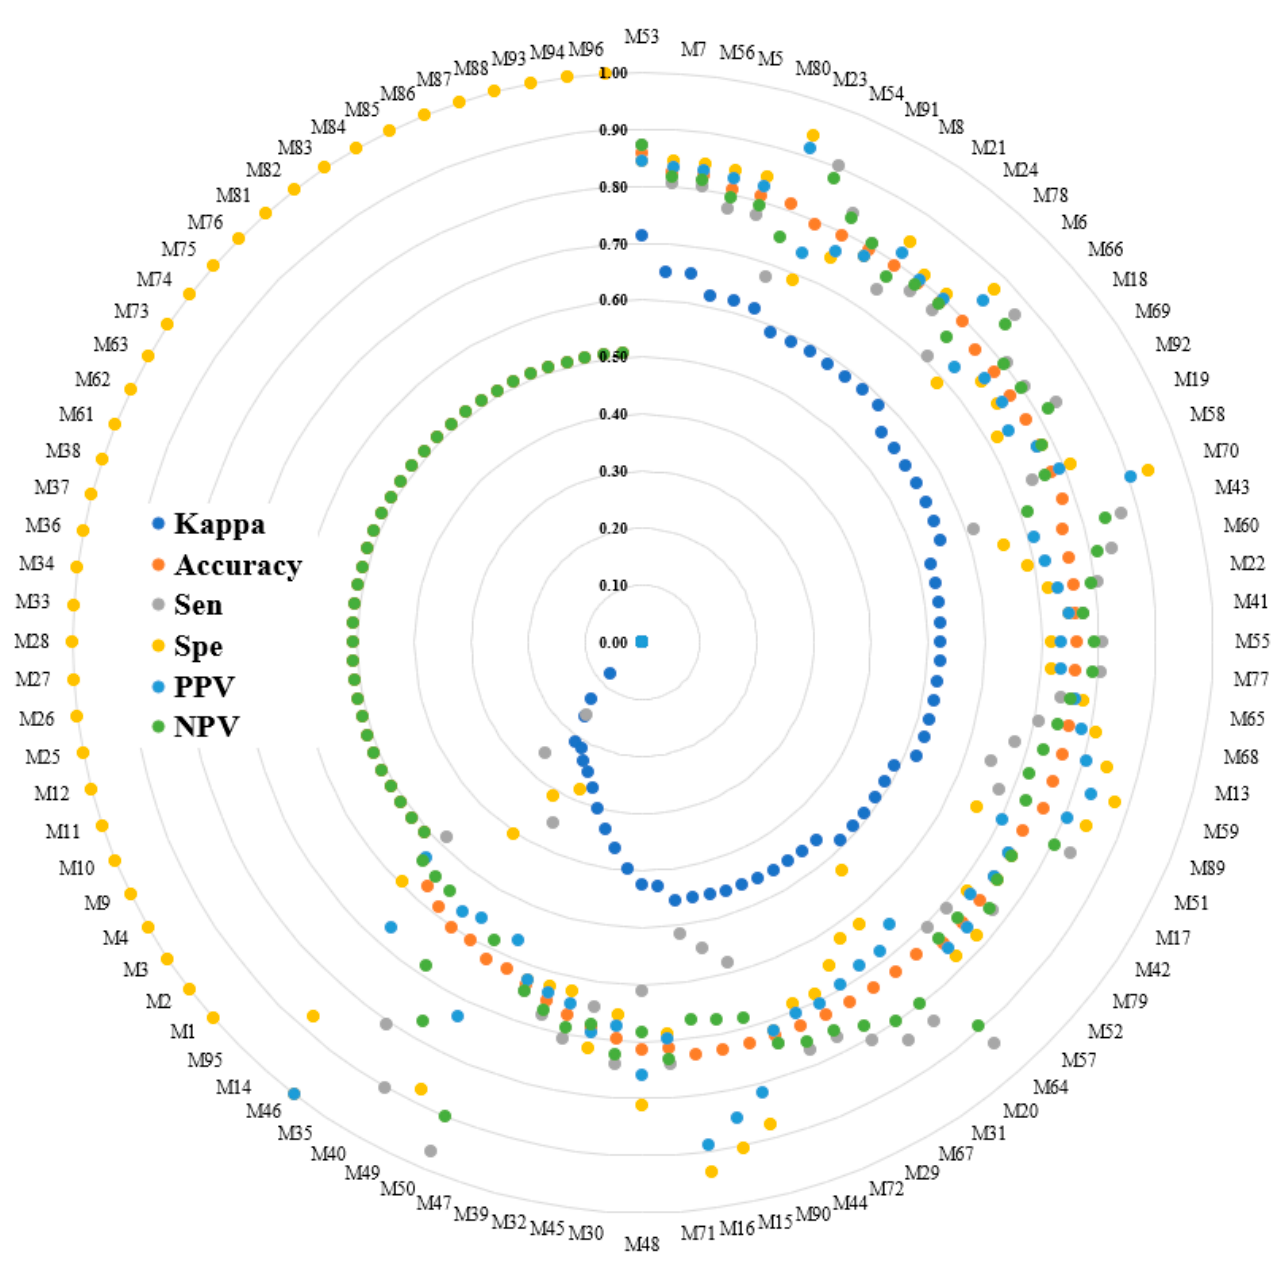
Figure 5. Radar plot of the six performance indices sorted in the ascending order of the kappa value for 96 models (the abbreviations are explained in the Appendix A). Sen represents the sensitivity, and Spe represents the specificity.